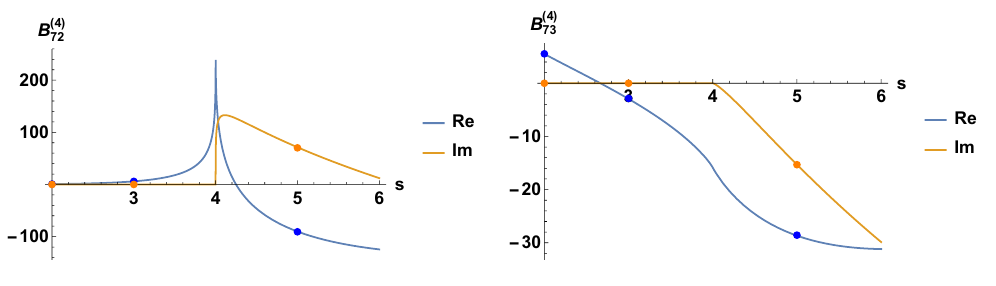
and B (4) . Note the singular behaviour at s = 4 m 2 ; ( m = 1). 72 73